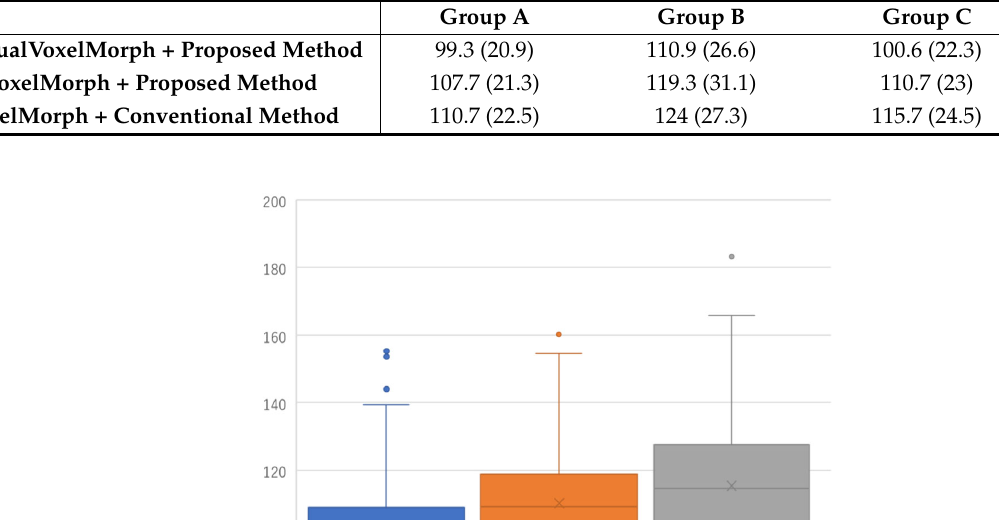
Table 3. RMSE average values of all evaluated methods. Values in parentheses represent standard deviation of RMSE.